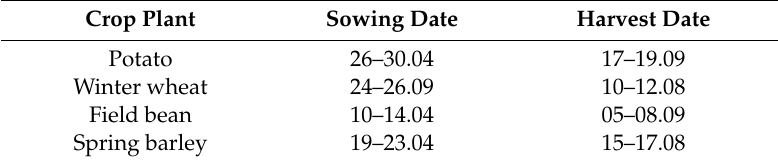
Table 2. Sowing and harvest dates of the crop plants included in the